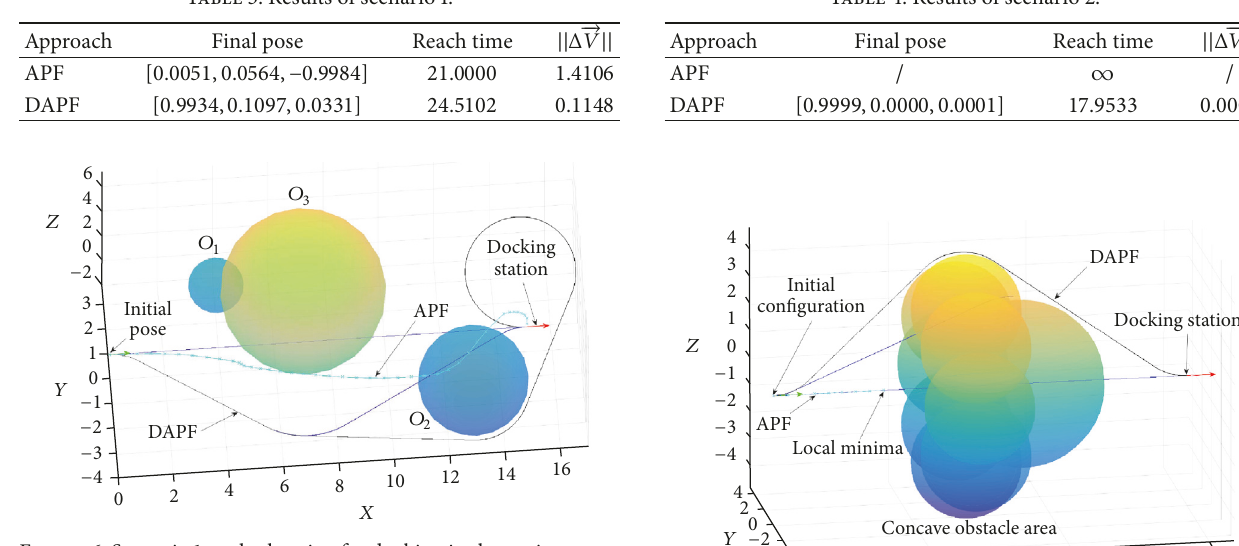
Figure 6: Scenario 1: path planning for docking in the environment with static and moving obstacles.